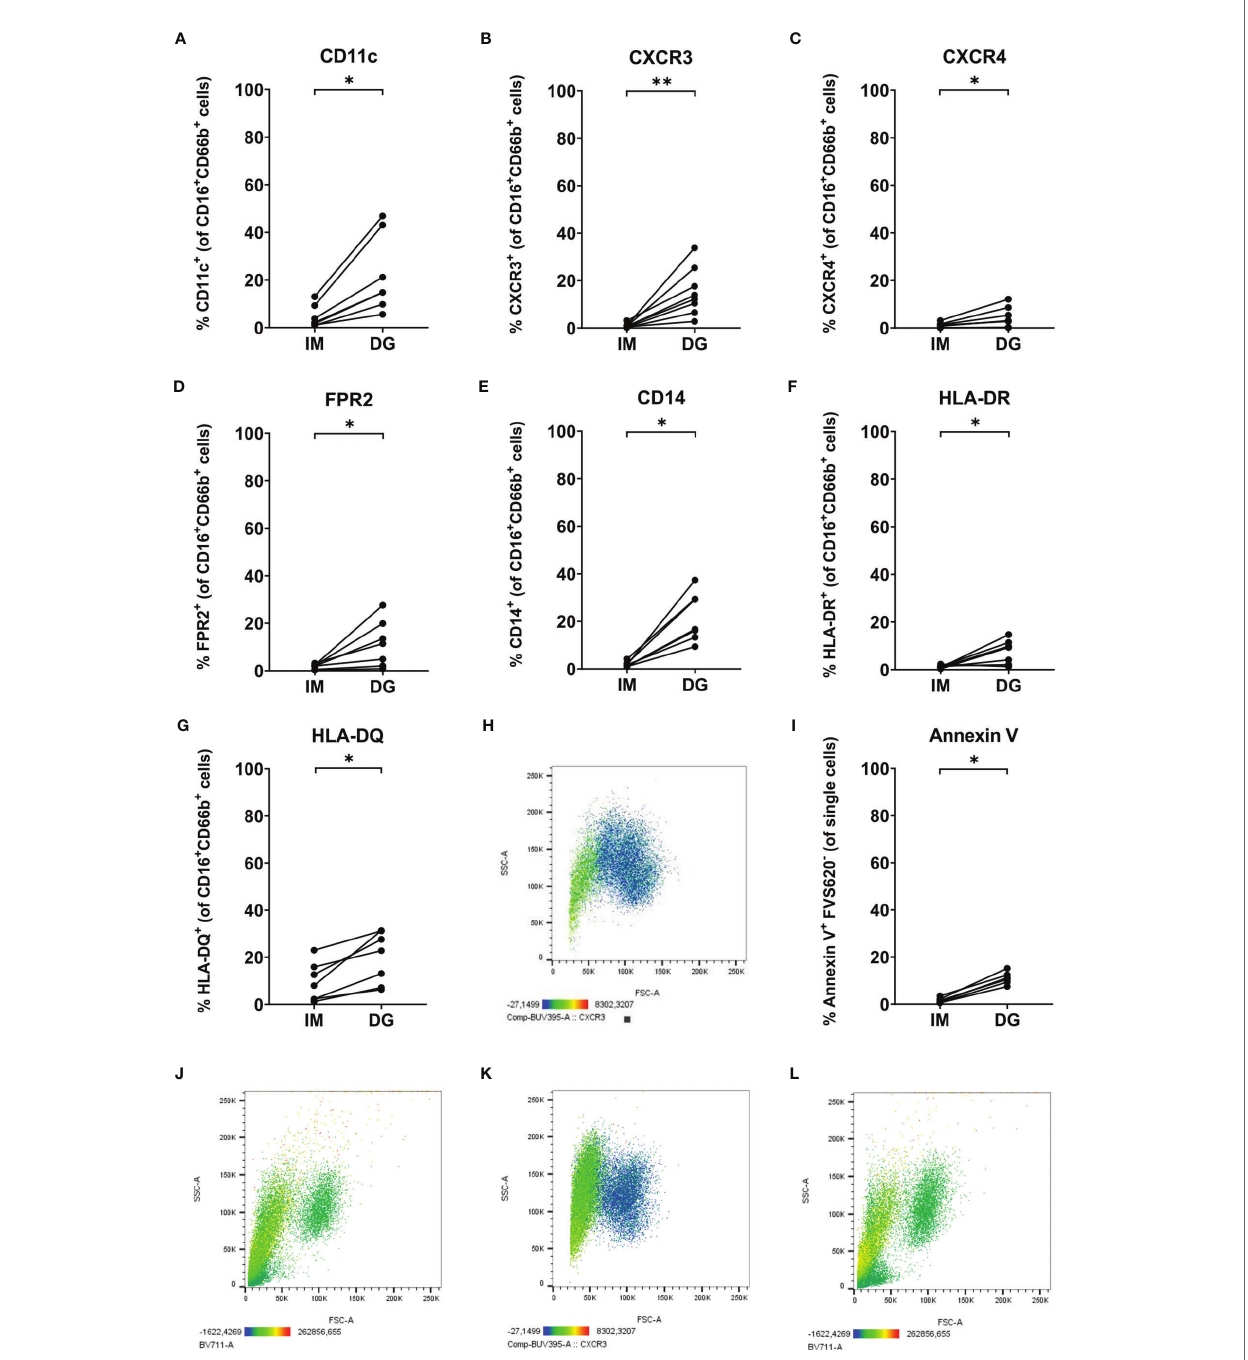
FIGURE 7 | Neutrophils puri fi ed by density-gradient centrifugation partially express markers atypical for neutrophils. Flow cytometry was used to evaluate the surface expression of (A) CD11c, (B) CXCR3, (C) CXCR4, (D) FPR2, (E) CD14, (F) HLA-DR and (G) HLA-DQ on neutrophils (gated as CD16 + CD66b + cells) isolated by immunomagnetic (IM) or density-gradient puri fi cation (DG) from peripheral blood of healthy donors. (H) CXCR3 (BUV395) staining (indicated by color code below the plot) on FSC/SSC plot of neutrophils puri fi ed by density-gradient centrifugation. (I) Annexin V and FVS620 staining on neutrophils isolated by IM or DG puri fi cation from peripheral blood of healthy donors. (J) Annexin V (BV711) staining (indicated by color code below the plot) on FSC/SSC plot of neutrophils puri fi ed by density-gradient centrifugation. (K, L) CXCR3 (BUV395) and Annexin V (BV711) staining (indicated by color code below the plot) on FSC/SSC plot of neutrophils puri fi ed by immunomagnetic puri fi cation immediately after a density-gradient puri fi cation. Results are represented as percentage of neutrophils positive for the marker. Results from each individual donor (n = 6-8) are connected by lines and were statistically analyzed by Wilcoxon matched-pairs signed rank test (*p < 0.05; **p < 0.01 for statistical differences between neutrophils puri fi ed with immunomagnetic or density-gradient